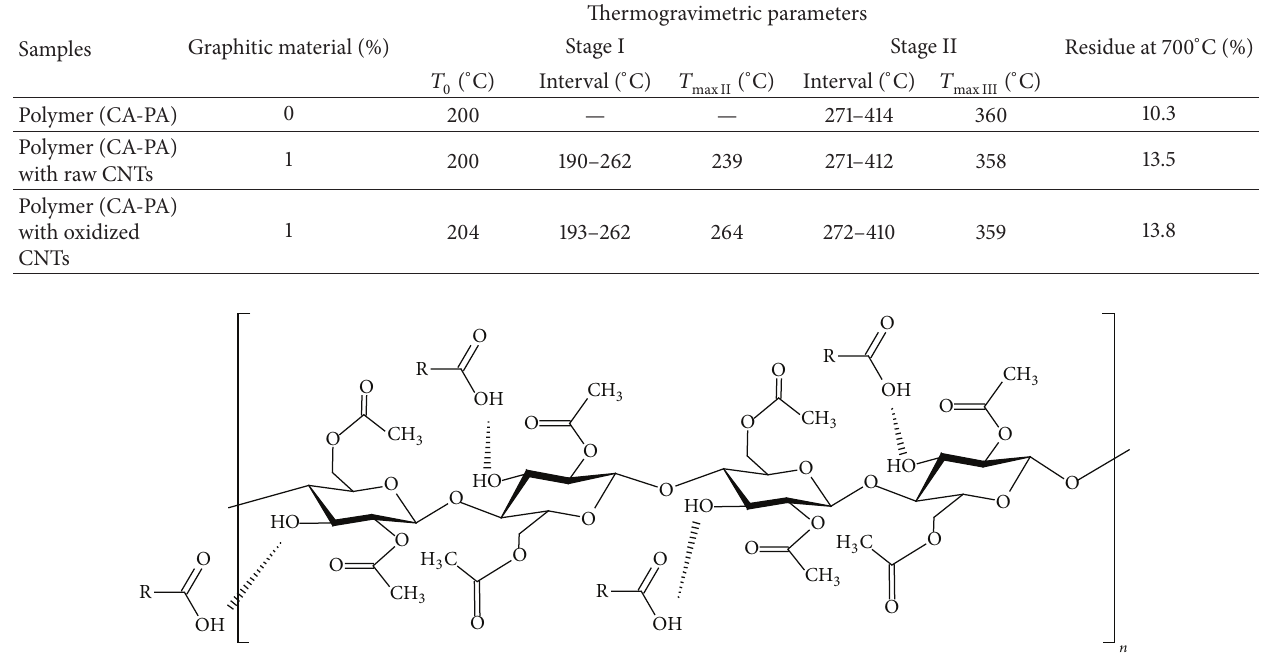
Figure 9: Mechanism based on reaction between carboxylic groups and acetyl groups